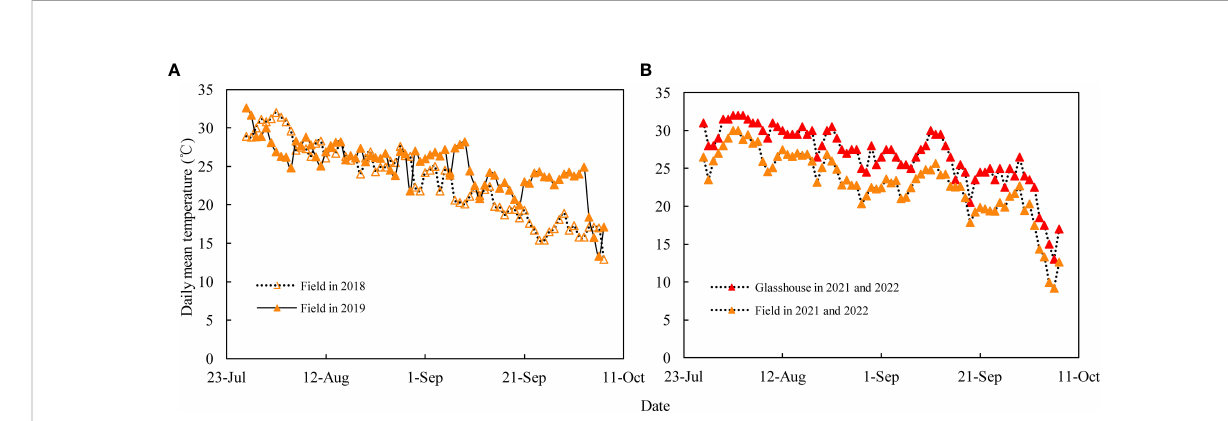
FIGURE 1 (A) Daily mean temperatures of the fi eld in 2018 and 2019, and (B) averaged daily mean temperatures for 2021 and 2022 in the fi eld and glasshouse during the grain fi lling